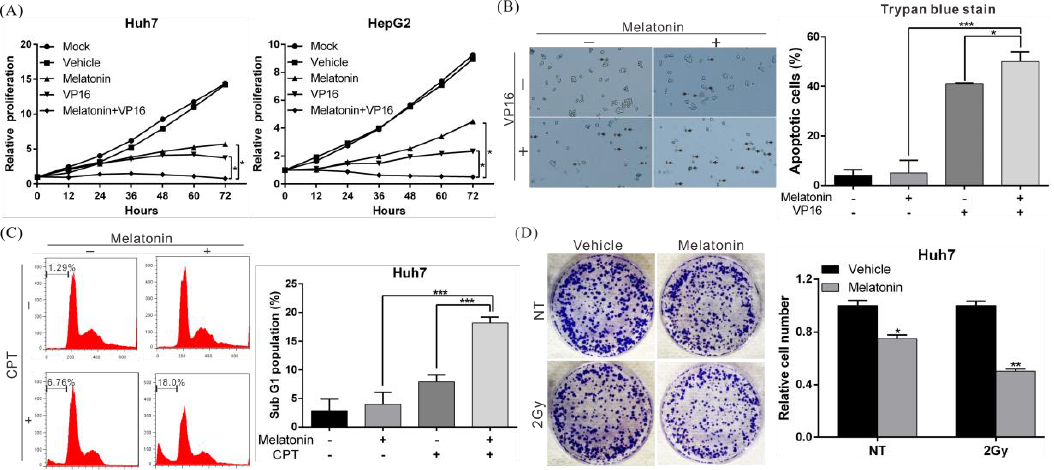
Figure 2. Melatonin enhanced the sensitivity of HCC cells to chemotherapy and radiotherapy. ( A ) The proliferation capacity of Huh7 and HepG2 cells treated with 1 mM melatonin, 200 µM etoposide (VP16), or both was monitored using an xCELLigence real-time cell analyzer. p < 0.05 (*), as assessed using Student ’ s t -test. ( B , C ) An trypan blue exclusion assay and flow cytometry showed that combined treatment with 1 mM melatonin significantly increased the cytotoxicity of 200 µM etoposide (VP16) and 1 µM camptothecin (CPT) in Huh7 cells. Data are expressed as the mean ± S.D. of three independent experiments. The arrows indicate the apoptotic cells. ( D ) Effect of melatonin on the radiosensitivity of Huh7 cells. Cells were irradiated with Cs-137 at a dose of 2 Gy, followed by treated with/without 1 mM melatonin for 24 h and then cultured for an additional 10 days in the absence of melatonin (left panel). The numbers of foci were counted, and the results are presented in the right panel. p < 0.05 (*), p < 0.01 (**), p < 0.001 (***). All experiments were performed in triplicate.